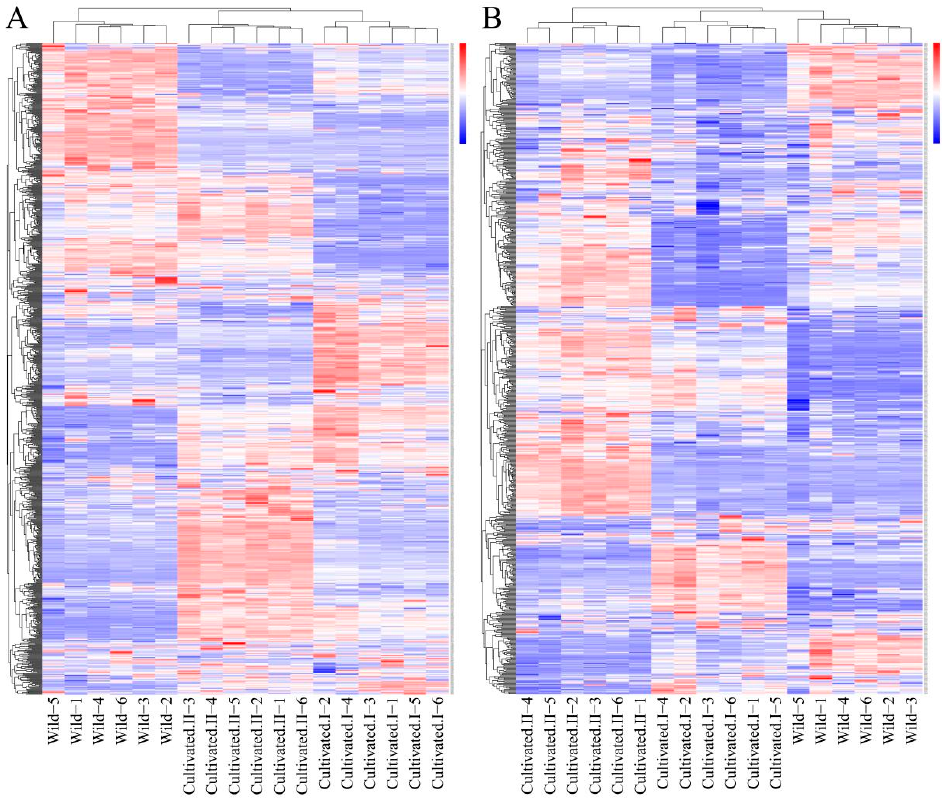
Figure 3. Cluster heatmap analysis of metabolites from different sources of YCH. ( A ) The metabolites detected in the positive ion mode. ( B ) The metabolites detected in the negative ion mode.